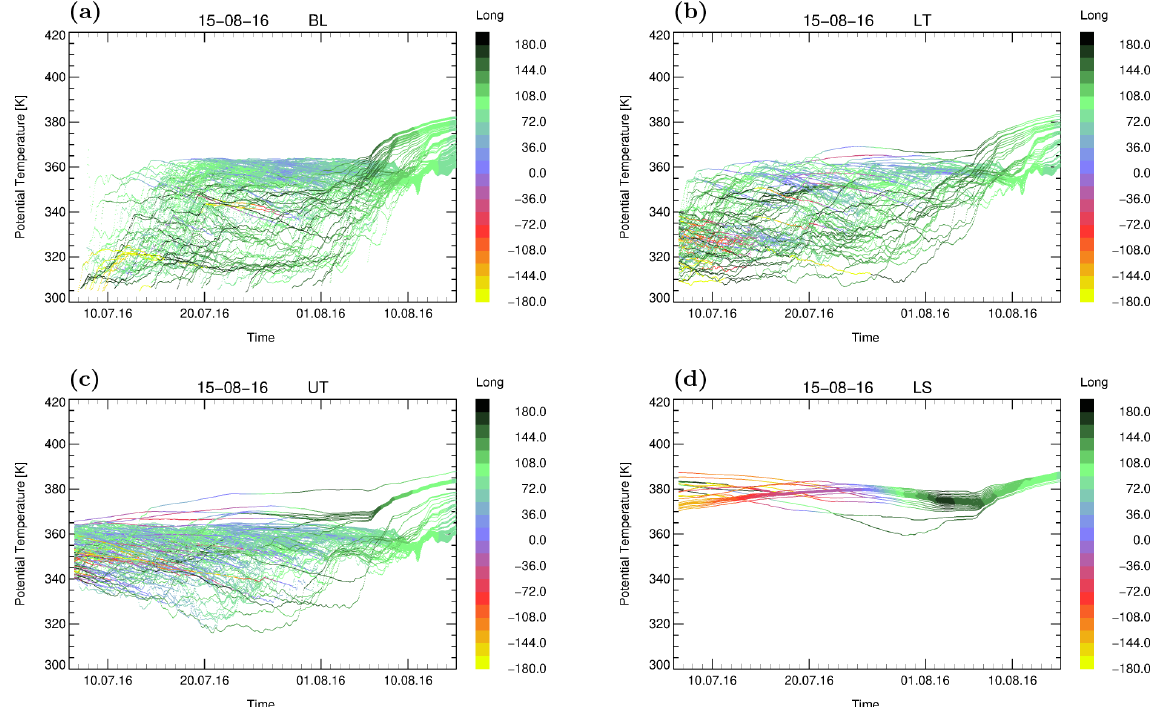
Figure 7. As Fig. 4 but for the no ATAL case on 15 August 2016 (Case 2). The trajectories are calculated in a pressure range between 140 and 92hPa (365 to 389K).